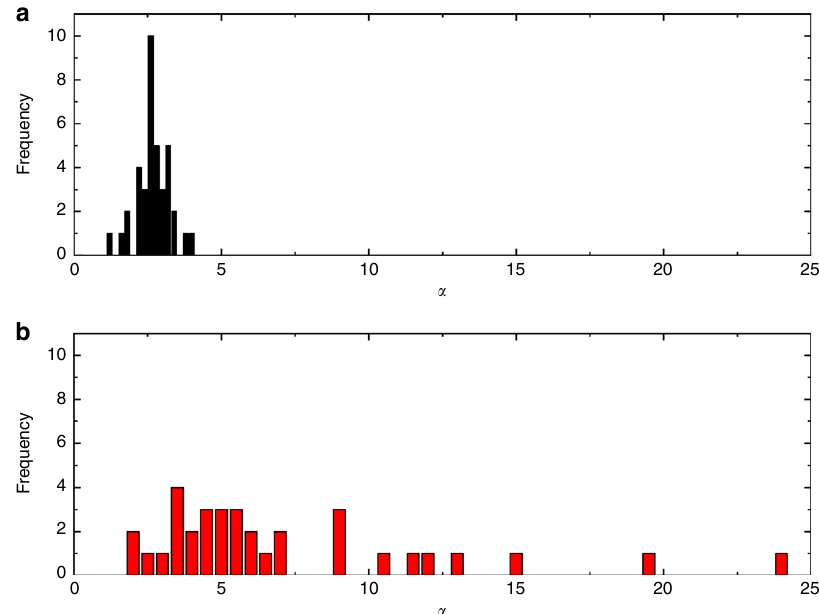
Fig. 3 Histograms of measured power law exponents. a Polydimethylsiloxane (PDMS) exponents (black) and b polycarbonate (PC) exponents (red). PDMS data approximate a normal distribution, whereas PC data does not. N = 38 for PDMS and N = 34 for